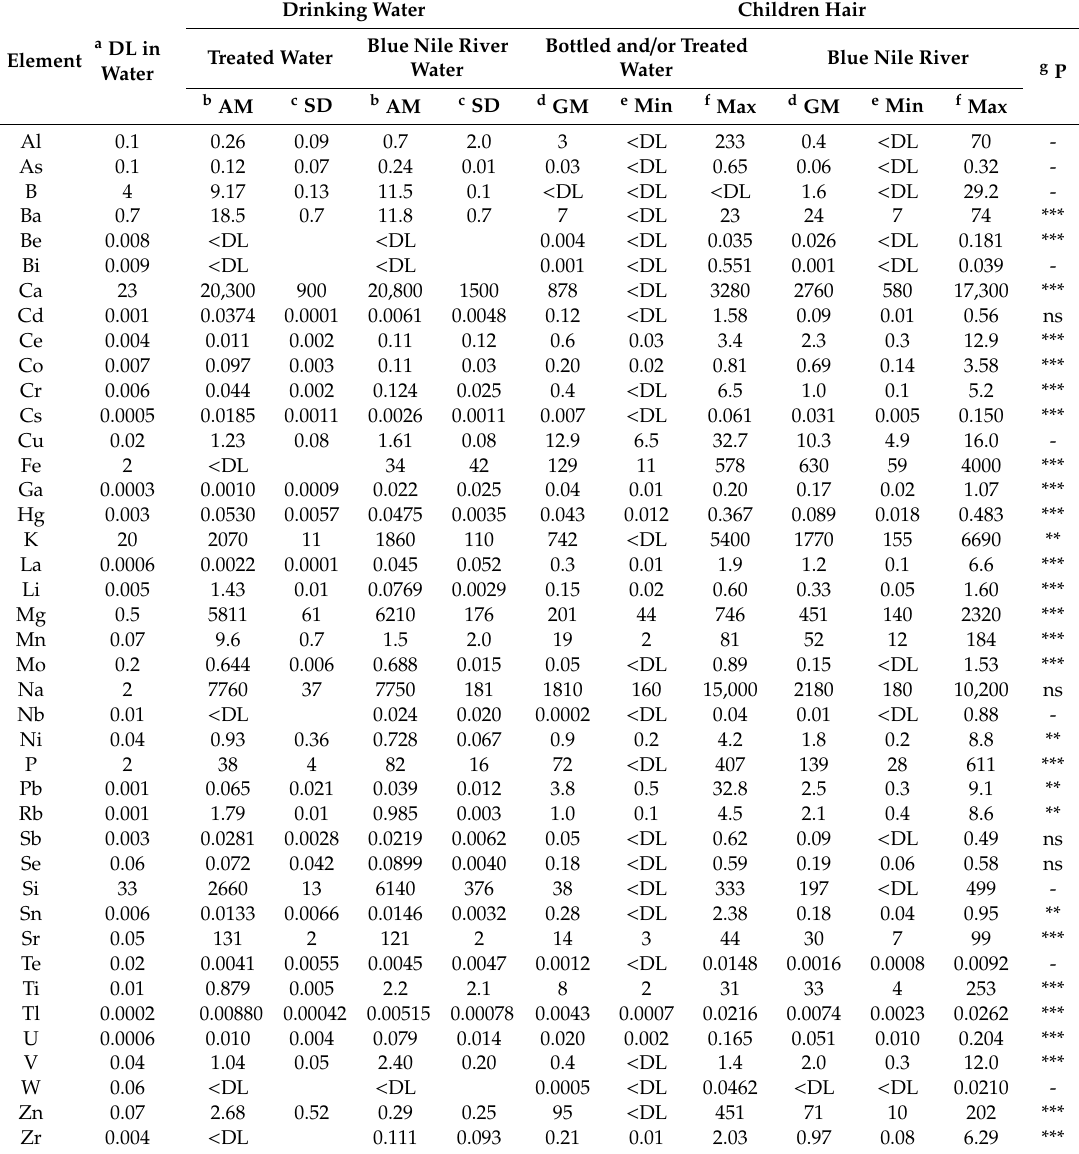
Table 4. Element concentrations in drinking water ( µ g L − 1 ) and in children’s hair (mg kg − 1 ) according to water